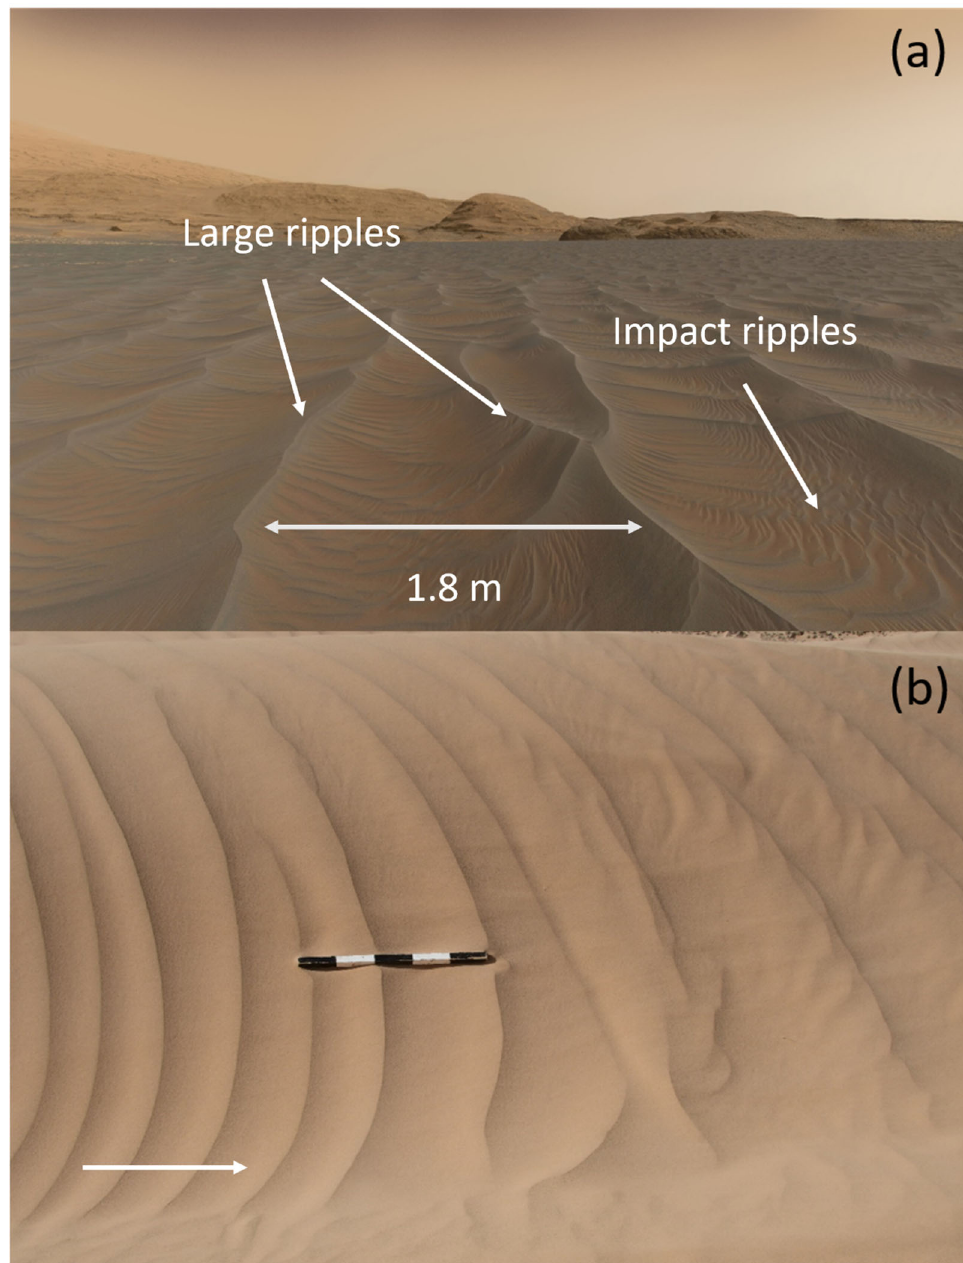
Figure 1. ( a ) Multiple ripple sizes at the Sands of Forvie ripple field in Gale Crater, imaged by the NASA MSL Curiosity rover. The wavelength of the largest ripples varies, but 2–3 m is common with smaller impact ripples between them. This picture shows the amazing complexity of the patterns that incorporate multiple ripple scales, probably due to multidirectional winds combined with medium and larger crests shielding parts of troughs from typically low-angle descents of saltating grains. For more information on this picture, see Figure 7 in [10]. Mastcam camera mosaic, sol 2991, NASA/JPL- Caltech/MSSS. ( b ) Large impact ripples near Merzuga dune field in Morocco during sand transport (from left to right indicated by the white arrow). The length of the scale bar is 0.5